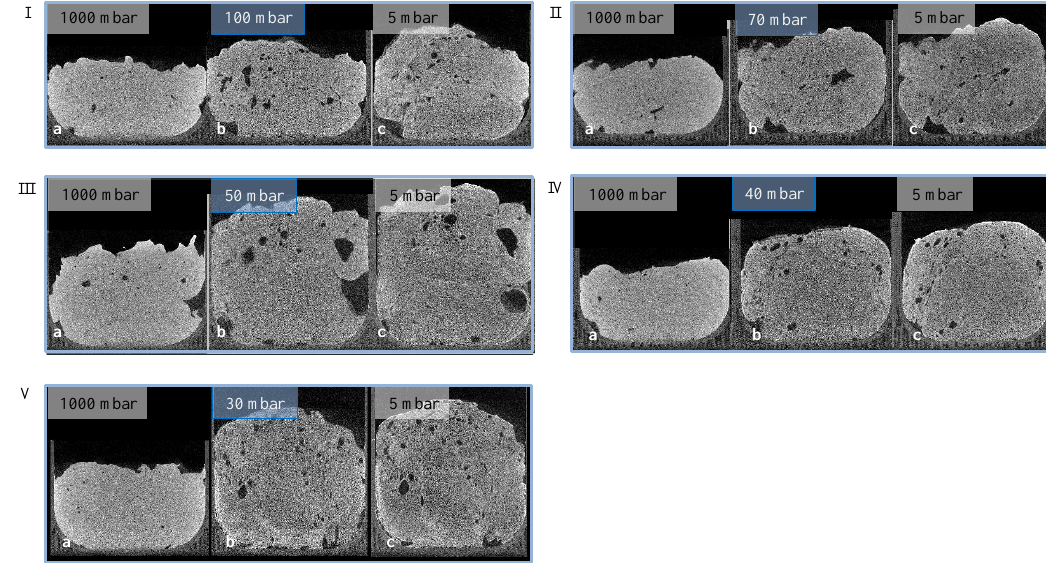
Figure 8. Holding stages (I: 100 mbar, II: 70 mbar, III: 50 mbar, IV: 40 mbar, V: 30 mbar) of a 5 °C tempered suspension with a pressure reduction rate of 10 mbar/s (( a ) suspension; ( b ) holding stage; ( c ) foam).